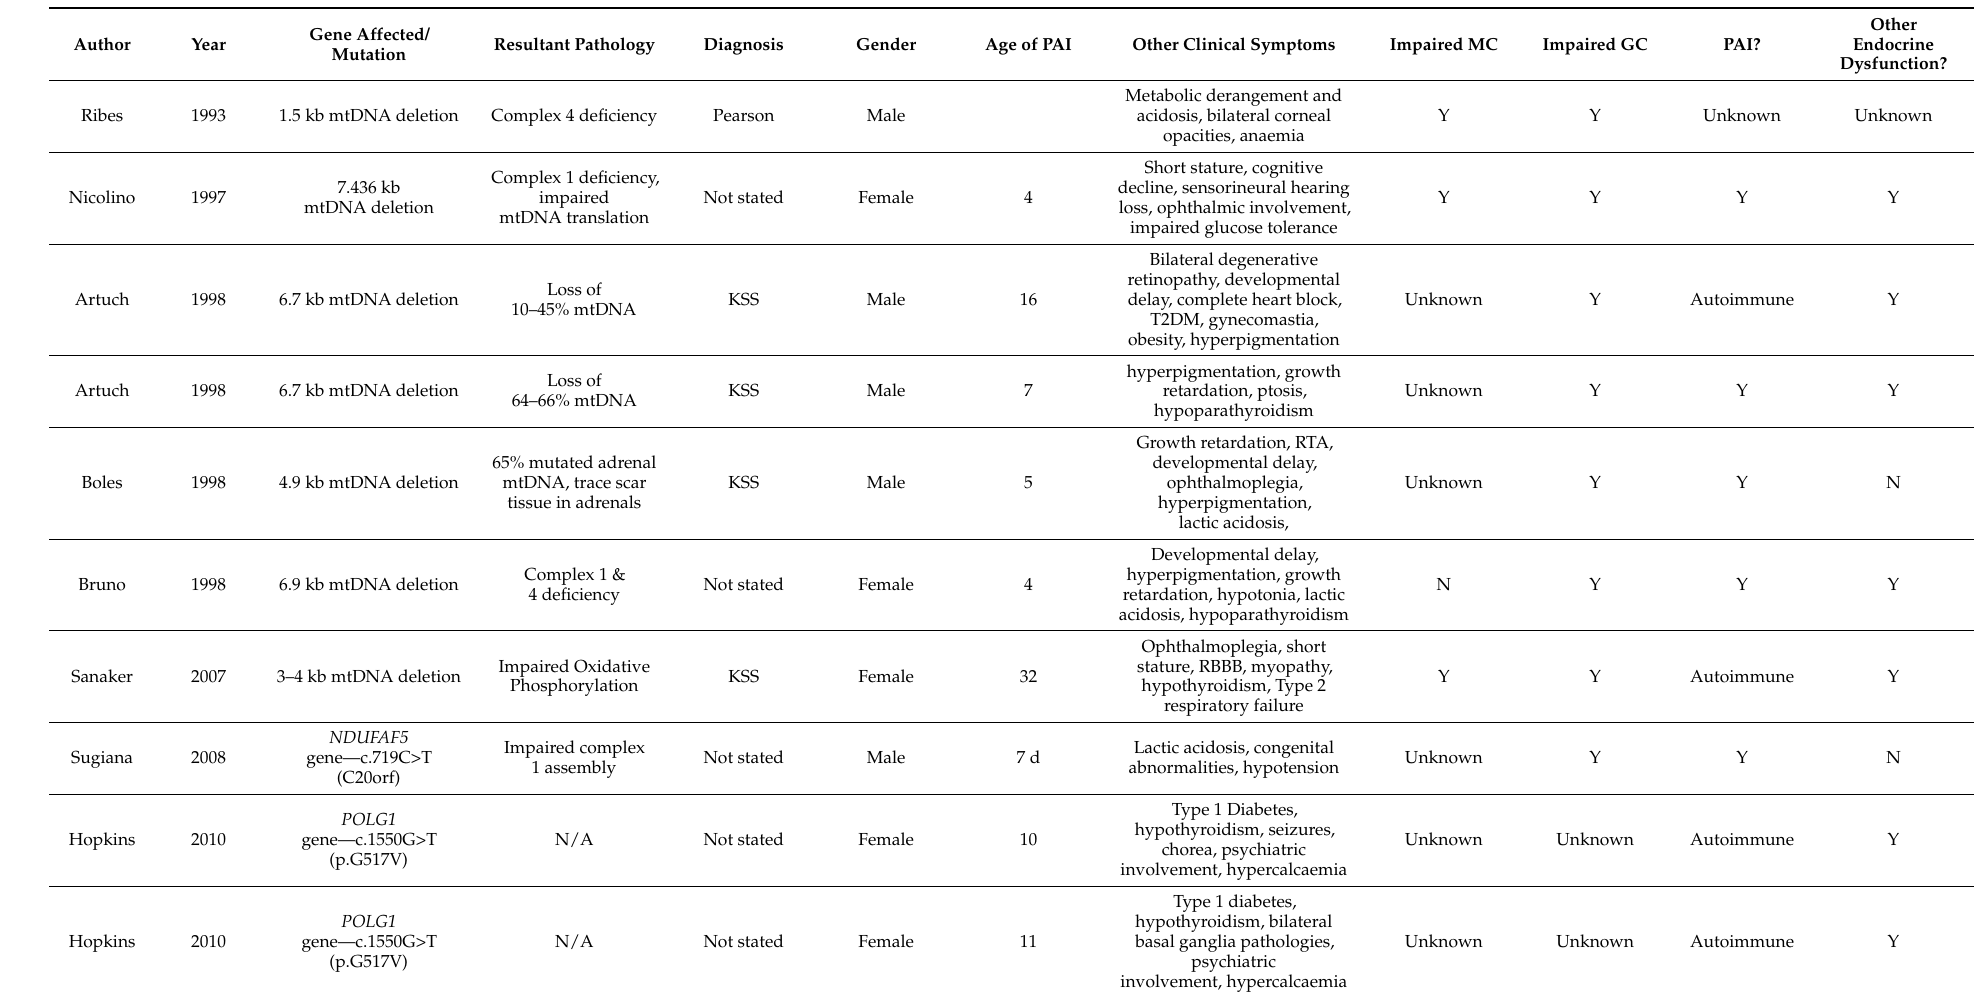
Table 1. Summary of all reported cases of adrenal insufficiency in mitochondrial